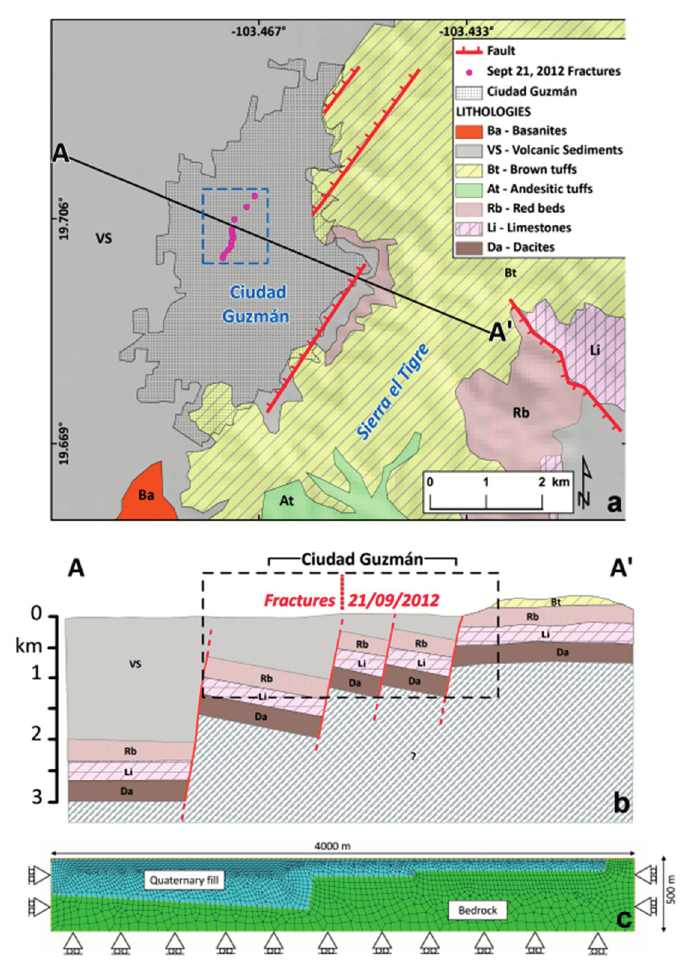
Figure 2. ( a ) Geological map of Ciudad Guzmán surroundings with the location of the 2012 fissures (purple dots, see Figure 3, here located with light blue dashed box). (Ba) Basanites—Quaternary deposits; (VS) Volcanic Sediments;